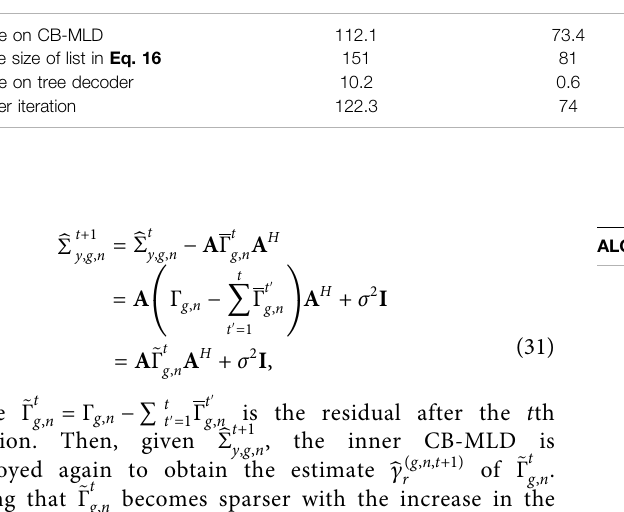
TABLE 4 | Runtime of the proposed receiver in different iterations, M (cid:1) 200 , K a (cid:1) 300 (unit: second). Iterative number